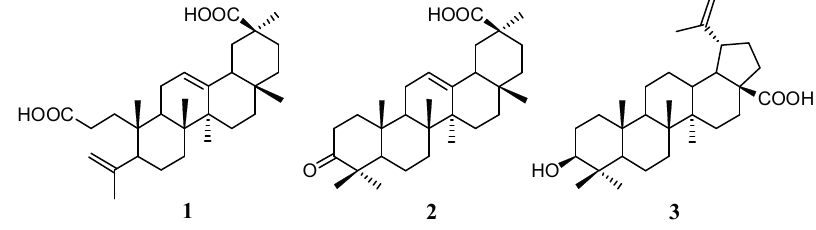
Figure 1. Chemical structure of the isolated triterpenoids from D. serrata